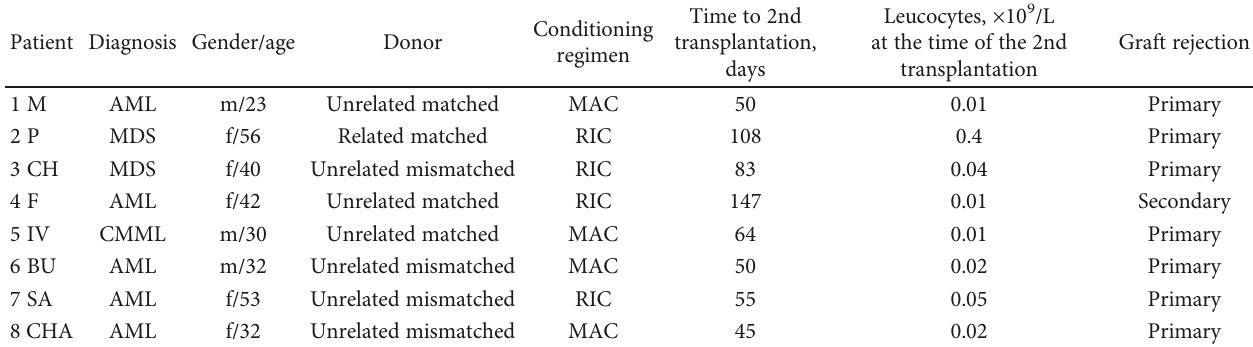
Table 1: Characteristics of the 1st transplantation.